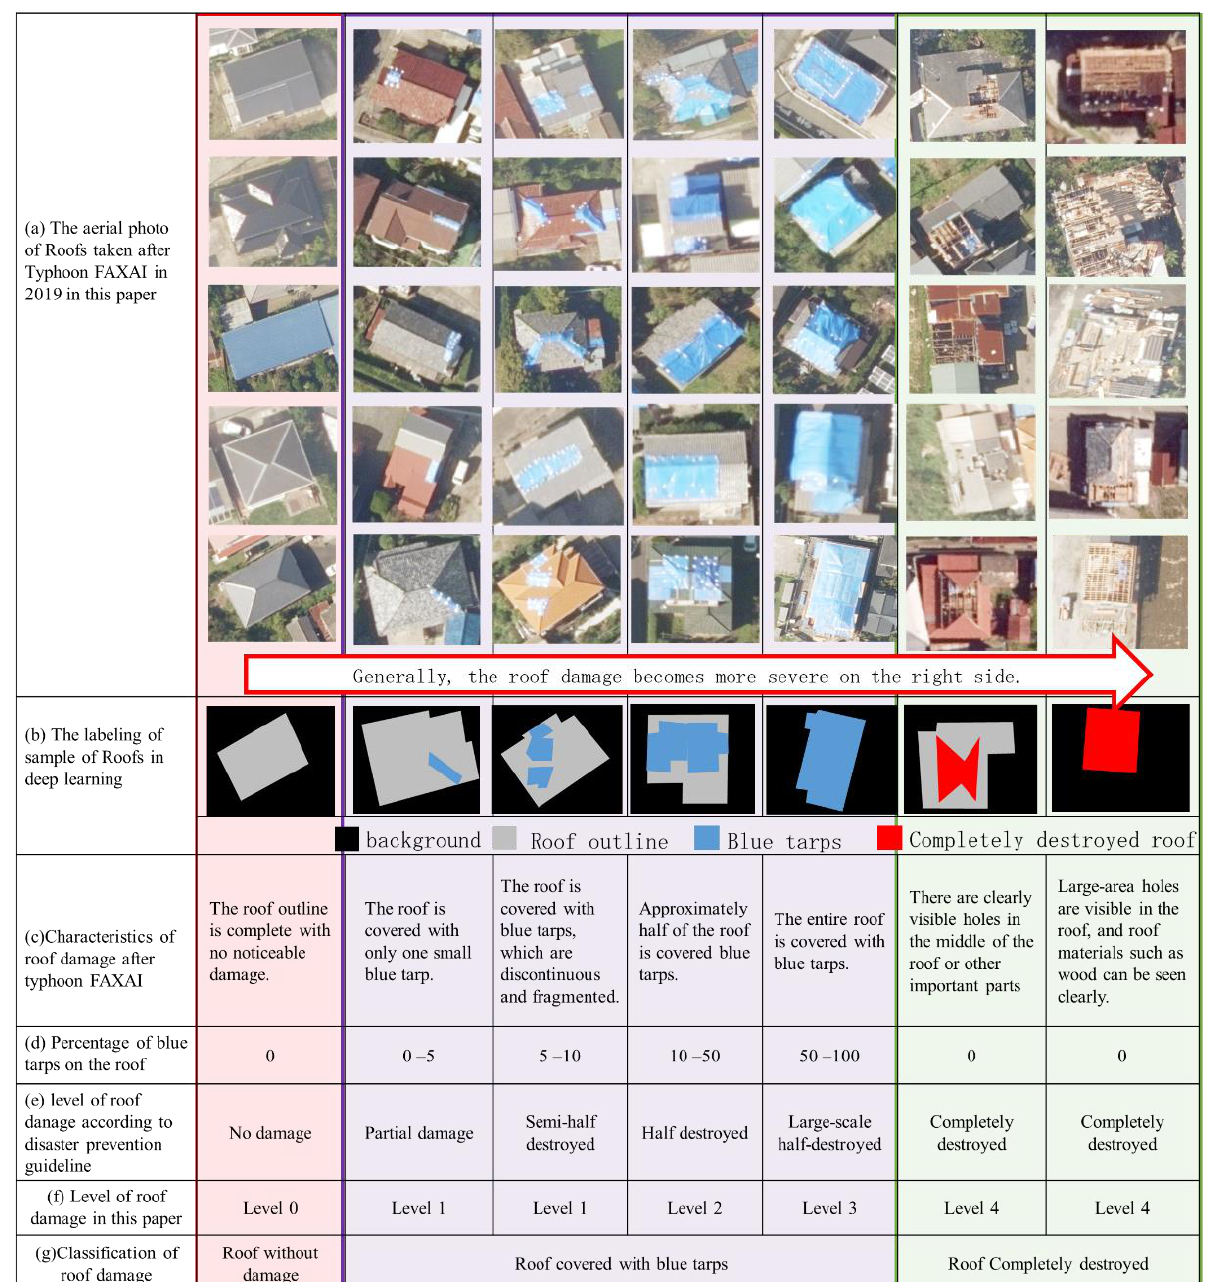
Figure 1. Appearance and level of roof damage in Typhoon Faxai in 2019. The left part with pink background represents the roof without damage, the middle part with purple background is the roof covered with blue tarps, and the right part with green background is the roof completely destroyed. Thus, With the direction of the red arrow in the Figure 1, the degree of roof damage increases.